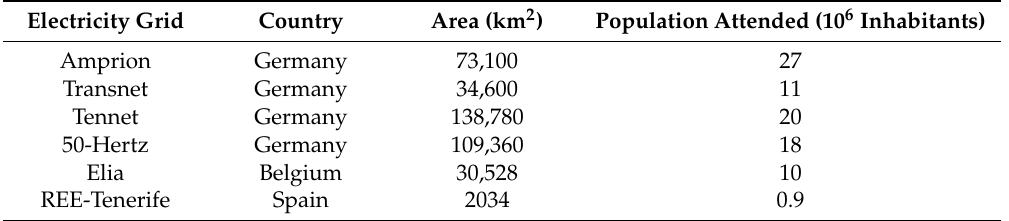
Table 1. Analyzed electricity grids. General